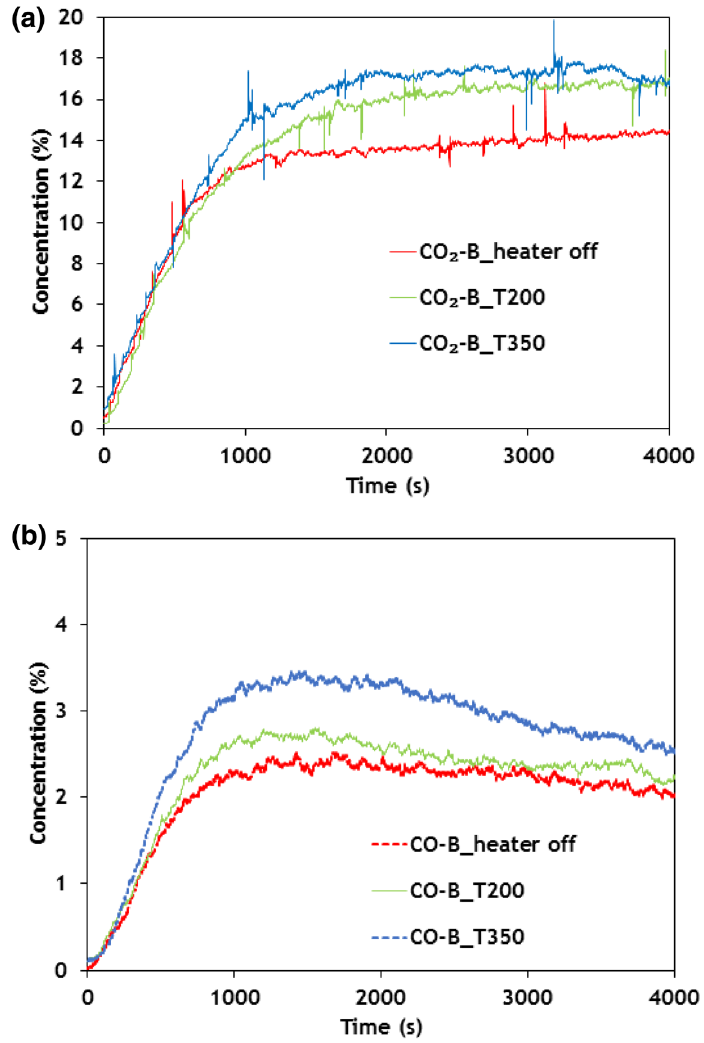
Fig. 16 Gas products of coal B at various temperatures a CO 2 and b